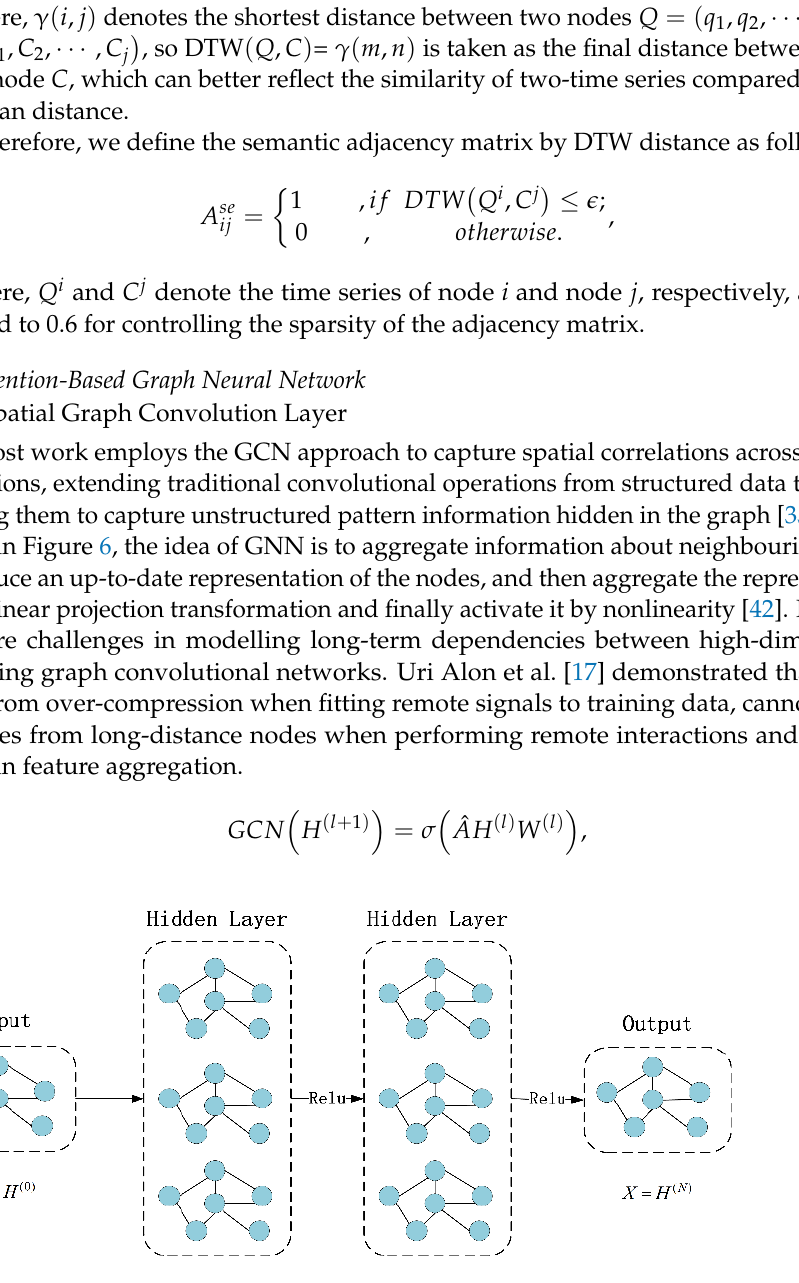
Figure 6. Graphical convolutional network to extract spatial features. H ( l ) is the node input feature representation, ˆ A ∈ R N × N is the adjacency matrix, representing the interaction relationship between nodes, and σ represents the non-linear activation